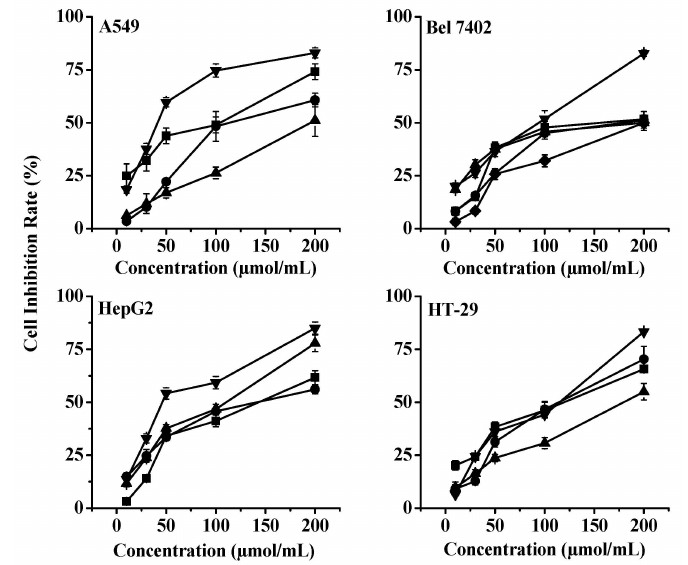
Figure 4. Inhibition rate of different monomeric compounds (A1 ( ◆ ), A2 ( ■ ), A3 ( ● ), A6 ( ▲ ), A7 ( ▼ )) in cancer cells. Cells (A549, Bel 7402, HepG2, HT ‐ 29) were treated for 24 h in the presence of the drug in medium. Cell viability was then determined by an MTT assay and is expressed as the mean ± SD of three separate experiments.